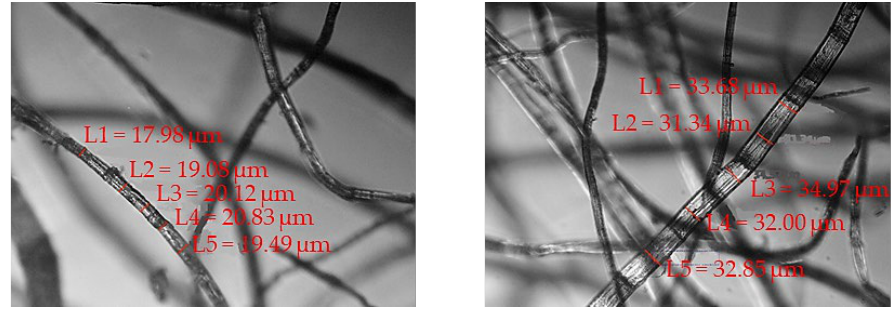
Figure 5. Diameter measurement graph of waste hemp fibers. Transverse and longitudinal morphology of waste hemp fibers—Scanning electron microscope photos of the transverse and longitudinal morphological structures of the discarded hemp fibers are shown in Figures 6 and 7.